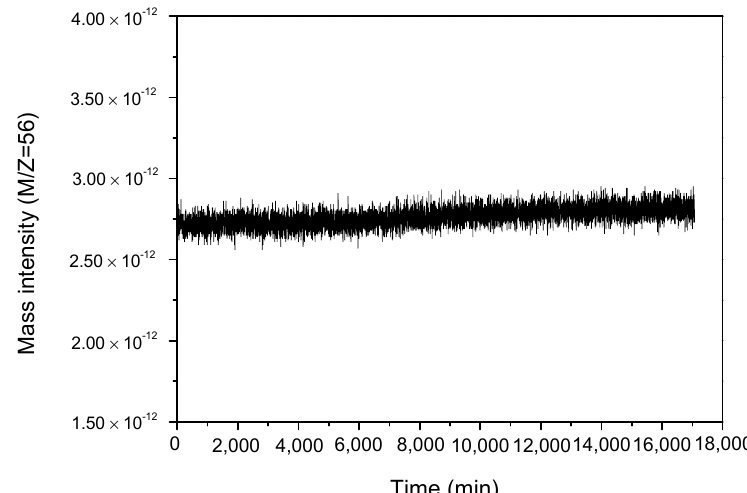
Figure 7. FTIR spectra of 350ZnCl 2 /SiO 2 in the fingerprint domain after pyridine sorption and evacuation at various temperatures. Absorbance peaks characteristic of strong Lewis (SL) is indicated.